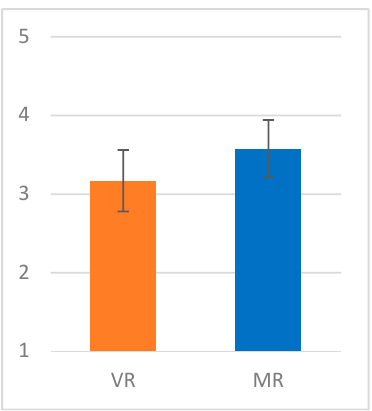
Figure 10. The average score of immersion and standard deviation for experience in each environment.